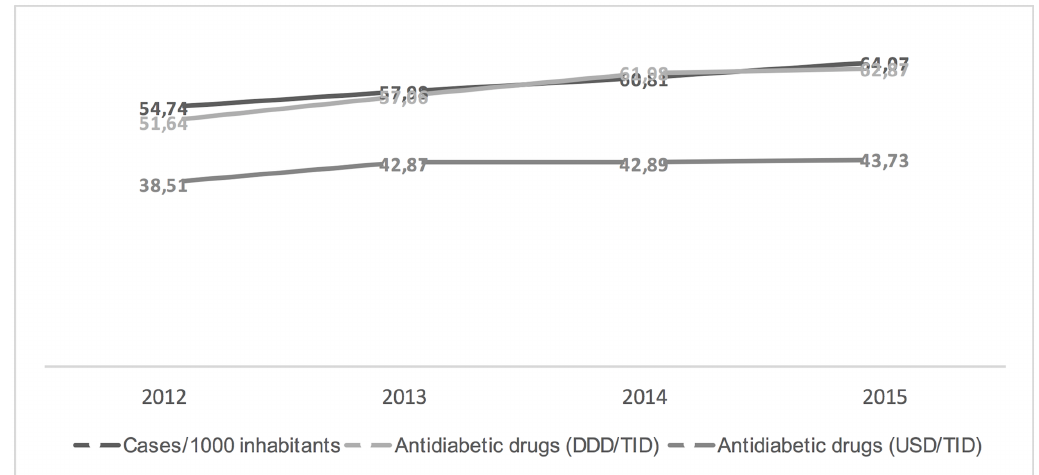
Fig 1. Trends in the diabetes mellitus morbidity (casesper 1000 inhabitants), antidiabetic drugs consumption (DDD/TID) and costs (USD/TID) in Poland, 2012–2015.